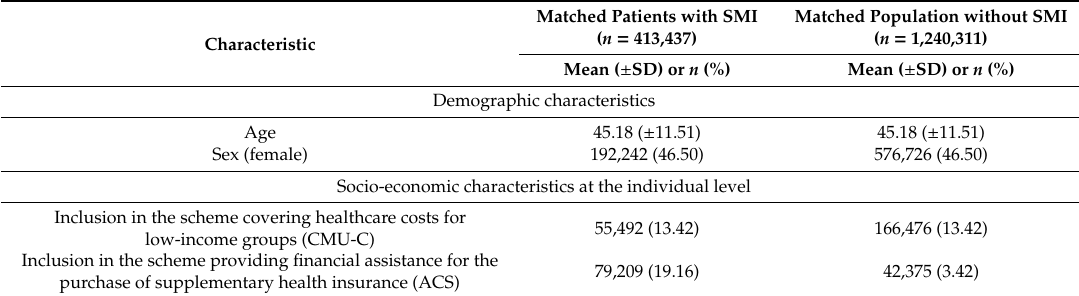
Table 2. Main characteristics of matched SMI patients and their controls without